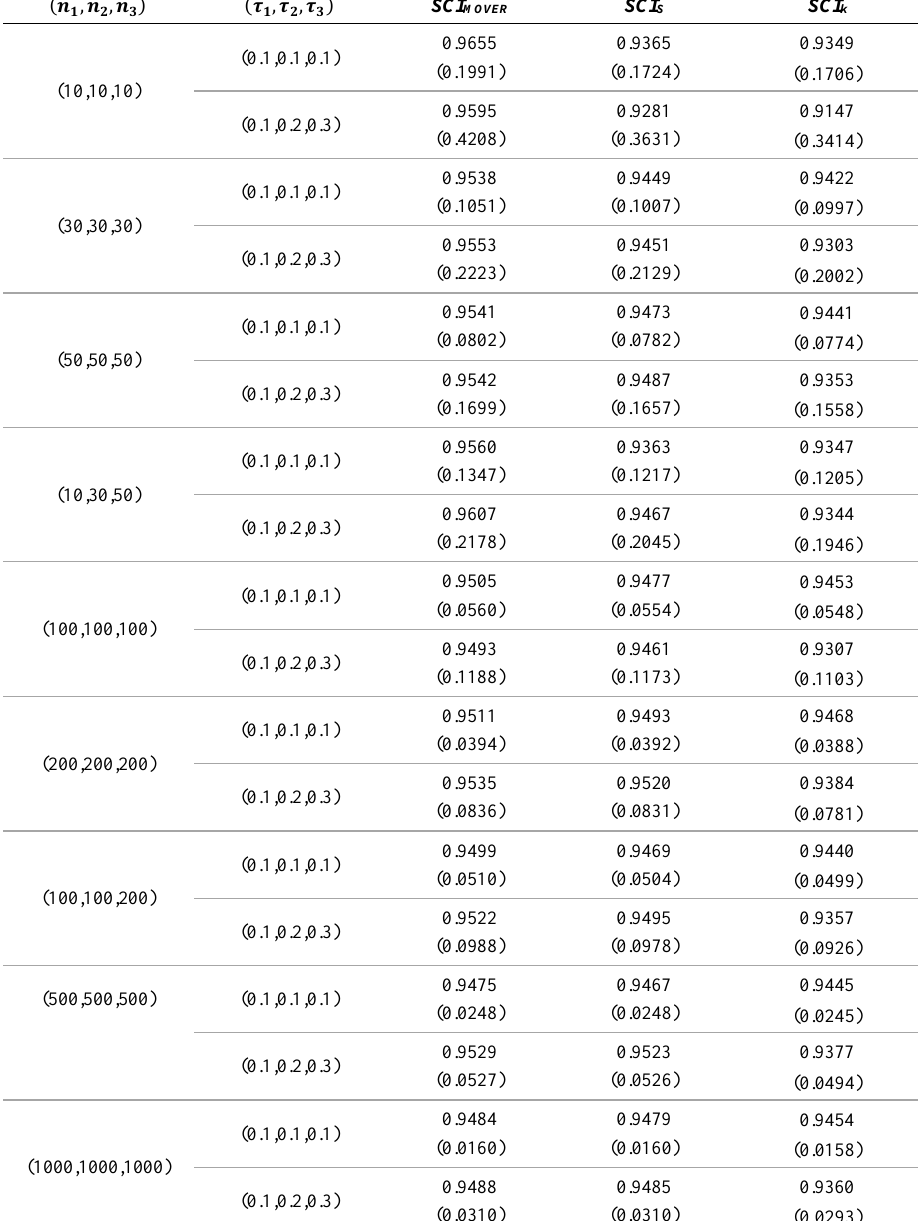
Table 1. The CP and the EL of the 95% two-sided SCIs for the means of normal distributions with known CVs: 3 sample cases (𝒏 𝟏 ,𝒏 𝟐 ,𝒏 𝟑